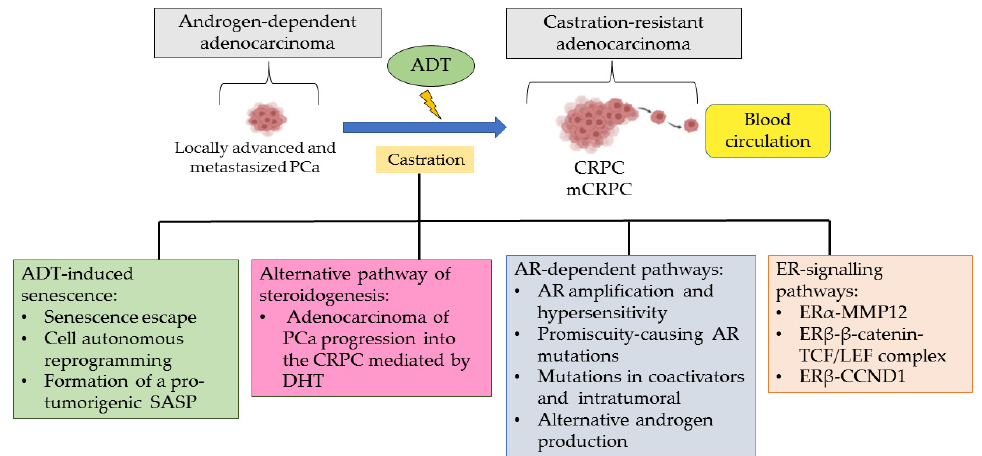
Figure 2. PCa development leading to CRPC progression after ADT treatment via AR-dependent